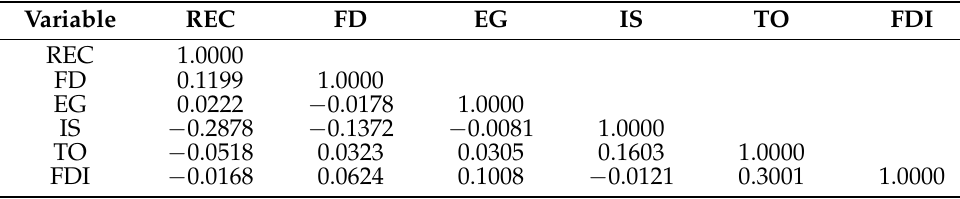
Table 2. Correlation matrix of the variables.